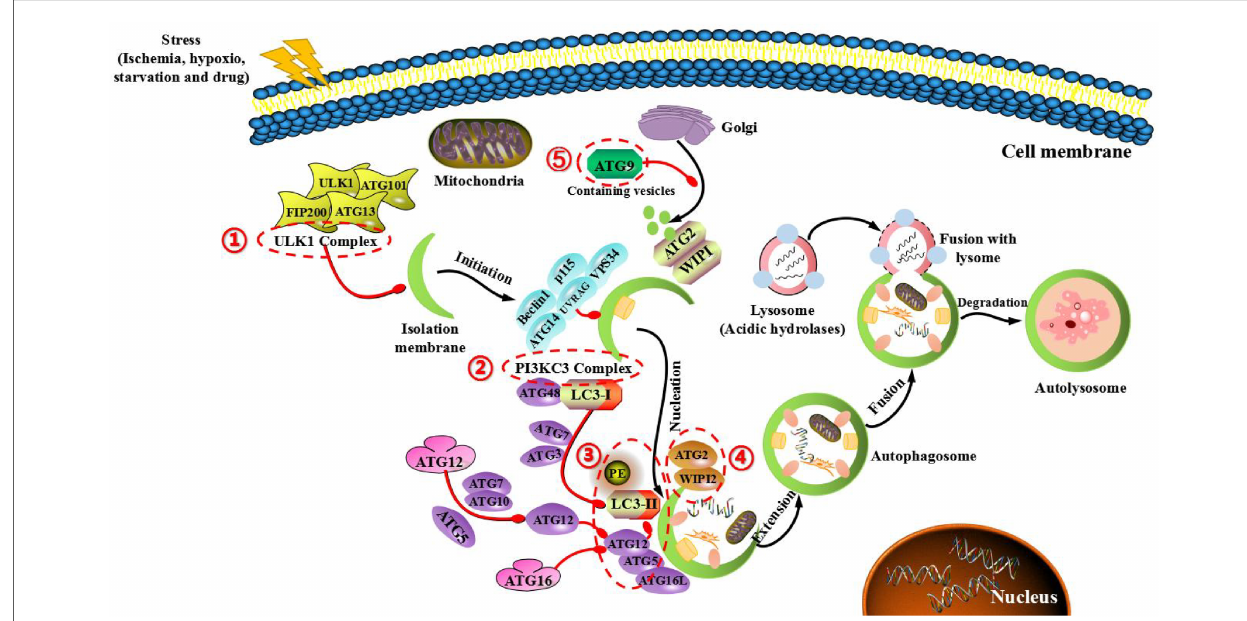
FIGURE 2 Main mechanism of autophagy in mammals and target genes for treating cardiovascular diseases. The main mechanism is that ATG protein forms fi ve functional groups (indicated in the red box). (1) ULK1 complex, composing of FIP200, ULK1, ATG13 and ATG101, which the mTOR complex of negative regulation. (2) BECLIN1-III PI3K complex, composing of BECLIN-1, VPS34, P115, AMBRA1 and ATG14 control the nucleation phase of autophagy. (3) Two full sample combination systems (ATG12-ATG5 and LC3 systems), which regulates the structure of autophagic precursor and autophagic body. (4) WIPI1/2 and ATG2 complexes control the extending autophagosomal membrane. (5) ATG9 retrieval complex, which the only multi-hop transmembrane protein involved in vesicle